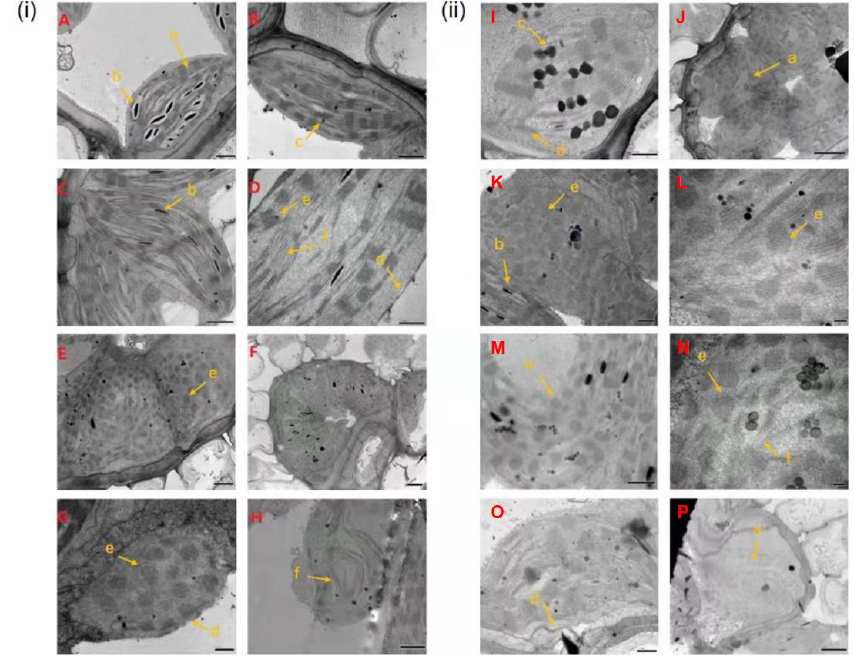
Figure 3. Chloroplast changes of rust-resistant Z. japonica (RR) and rust-susceptible Z. japonica (RS) after inoculation with P. zoysiae . ( i ) Inoculated RR leaves; ( ii ) Inoculated RS leaves; ( A , I ) Non-inoculation; ( B , J ) 1 day post inoculation (dpi); ( C , K ) 3 dpi; ( D , L ) 5 dpi; ( E , M ) 8 dpi; ( F , N ) 10 dpi; ( G , O ) 15 dpi; ( H , P ) 20 dpi. (a) chloroplast; (b) starch granule; (c) plastid globule; (d) chloroplast membrane; (e) granule; (f) matrix thylakoid.